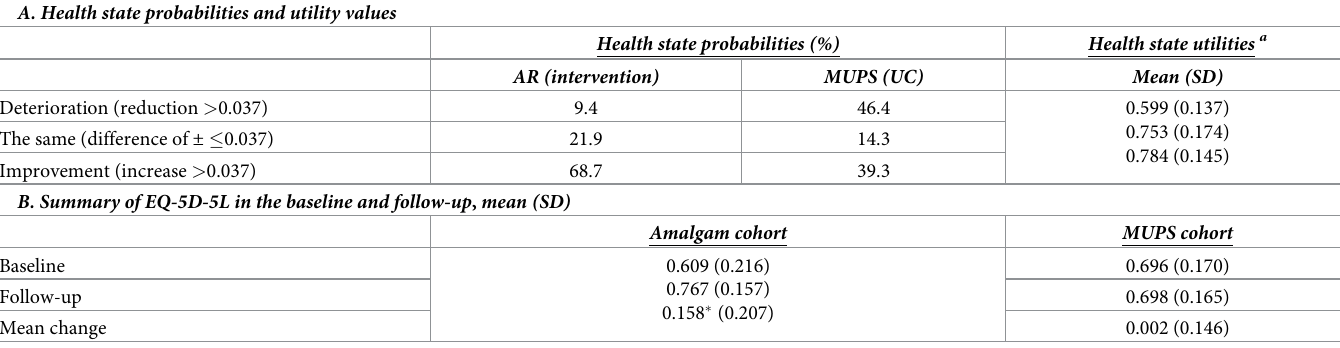
Table 2. Utility and probability parameters in different health